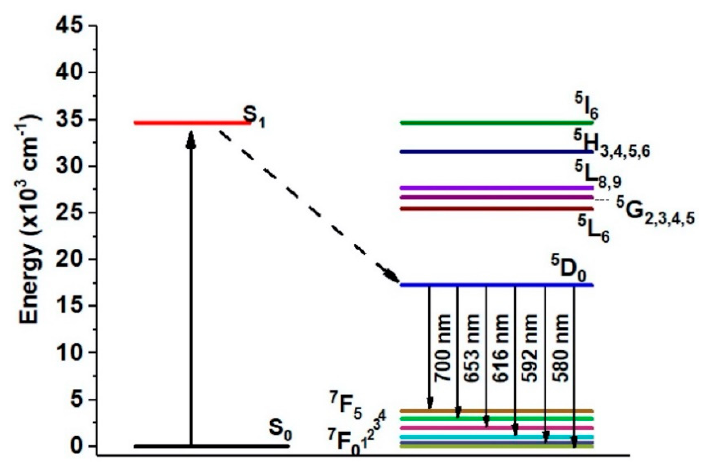
Figure 11. Partial energy level diagram of 3 : [Eu(OOCC 6 H 5 ) 3 · (HOOCC 6 H 5 ) 2 ].